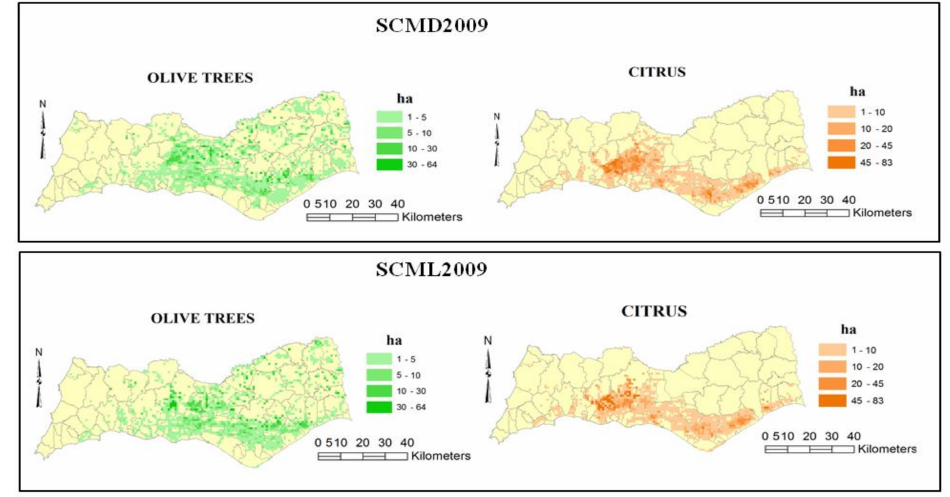
Figure 4. The examples of disaggregated units in the Algarve Region; source: model